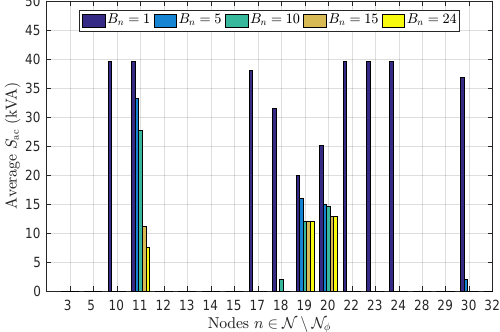
Figure 10. Average inverter